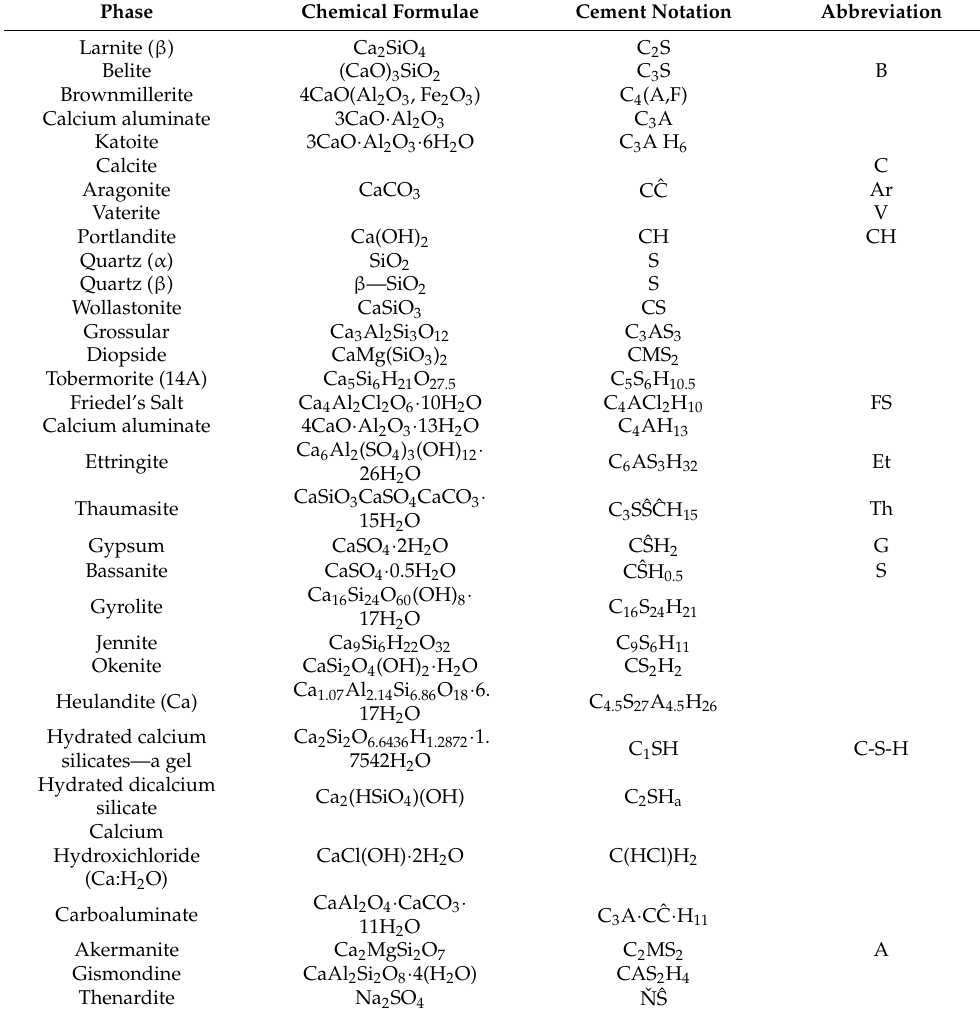
Table A1. chemical formulae, cement notation and abbreviations of mineral